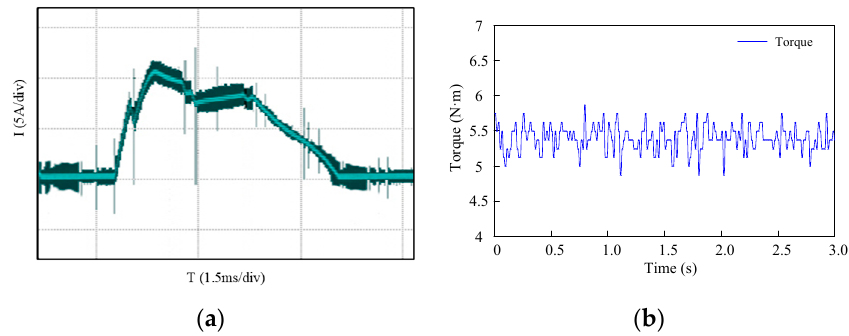
Figure 16. Waveforms of NUTSF at 500 r/min: ( a ) current; ( b ) torque.